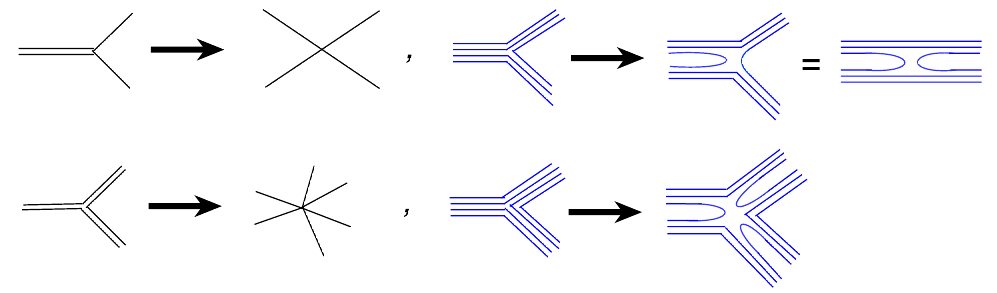
Figure 9 . Pulling apart a mesonic double line into a pair of single quark lines. The upper panel shows this process in terms of the single/double line notation introduced in (cid:12)gure 4; the lower panel depicts the same splitting in terms of the four individual O ( n ) index strands carried by the meson (cid:12)eld.